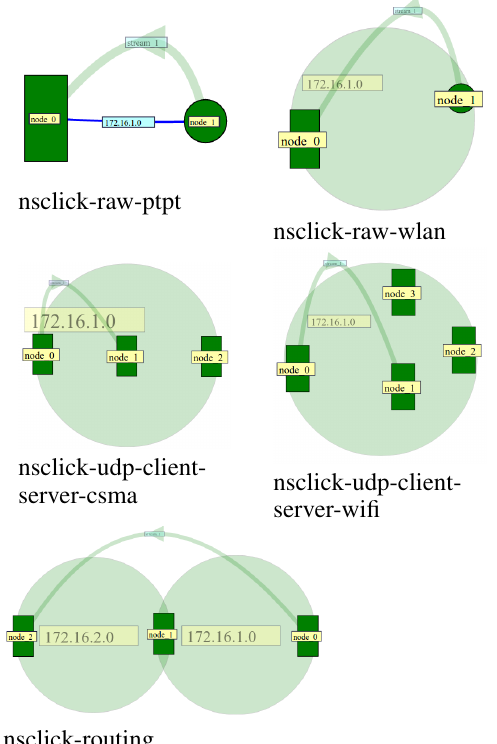
Fig. 7. The five Click Examples provided with the ns-click distribution.